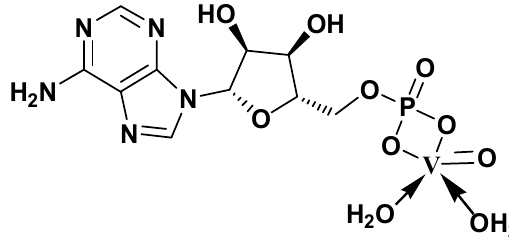
Figure 2. Proposed structure of the oxidovanadium(IV)–AMP complex.